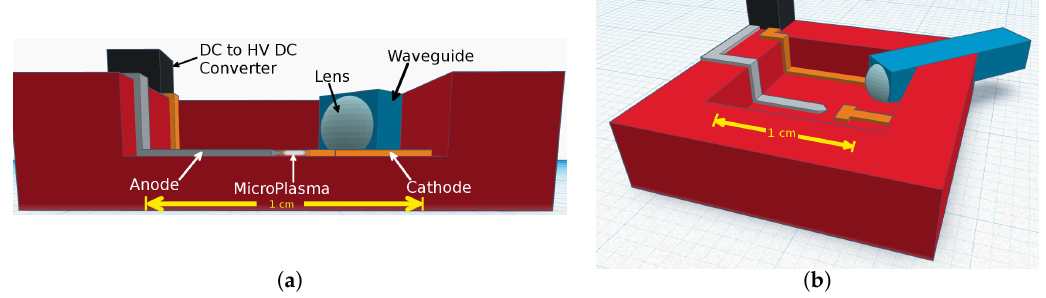
Figure 1. ( a ) Cross-section view of the device and its components. ( b ) 3D computer-aided design (CAD) model of the theoretical